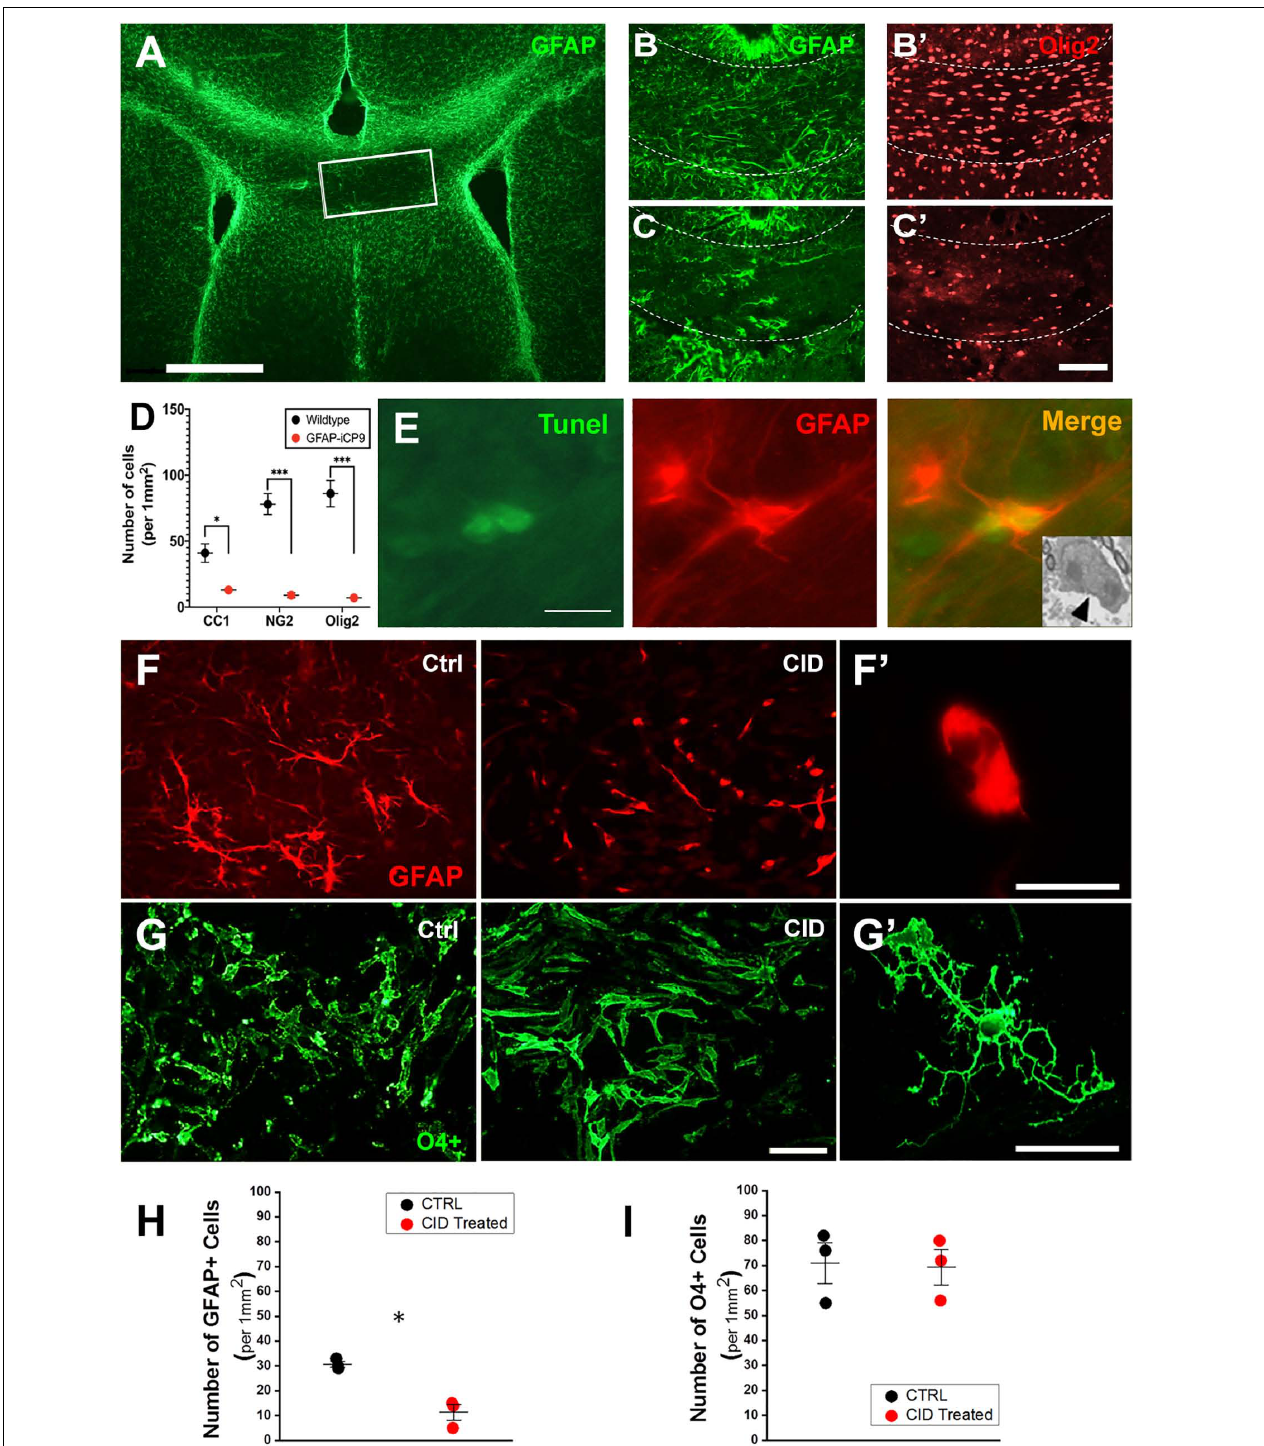
FIGURE 2 | Oligodendrocyte lineage cells are not directly affected by CID treatment but lost following astrocyte ablation in vivo . (A) Local delivery of CID to the corpus callosum (outlined box) of P30 GFAP-iCP9 animals results in highly localized loss of GFAP+ astrocytes (green) after 24 h. (B,C) Representative images from WT (B) or GFAP-iCP9 (C) animals 12 h after local delivery of CID to the corpus callosum labeled for astrocytes (GFAP, green) and oligodendrocyte lineage cells (Olig2, red). The loss of GFAP+ astrocytes was accompanied with local reductions in Olig2+ oligodendrocyte lineage cells. (D) Graph representing numbers of CC1+, NG2+, and Olig2+ cells per unit area in wildtype and GFAP-iCP9 treated mice. (E) 12 h after CID delivery, Tunnel+ (green)/GFAP+ (red) cells were present in